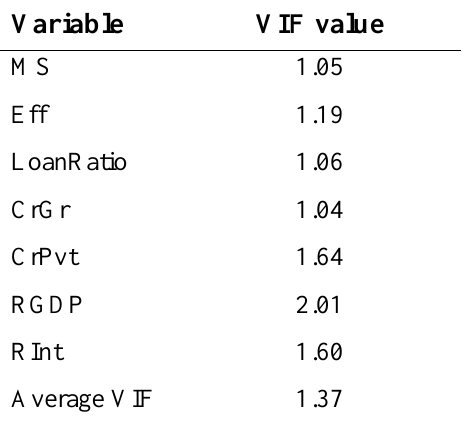
Table 2: VIF values of independent variables